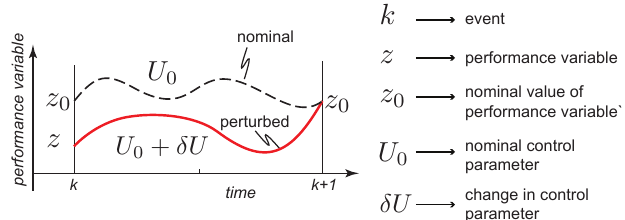
Figure 1. Key idea behind event-based discrete control: The nominal value of the performance variable z 0 is tracked at event k and k + 1 spread over time. The nominal values for the control parameters are U 0 . When the system is perturbed, the performance variable for the perturbation is z k = z (cid:54) = z 0 . Our goal is to use the measurement at k , z − z 0 to find the correction in control U 0 + δ U such that at the event k + 1, the performance variable z ( k + 1 ) = z 0 . Note that the time between events k + 1 and k is typically of the order of the time scale of the